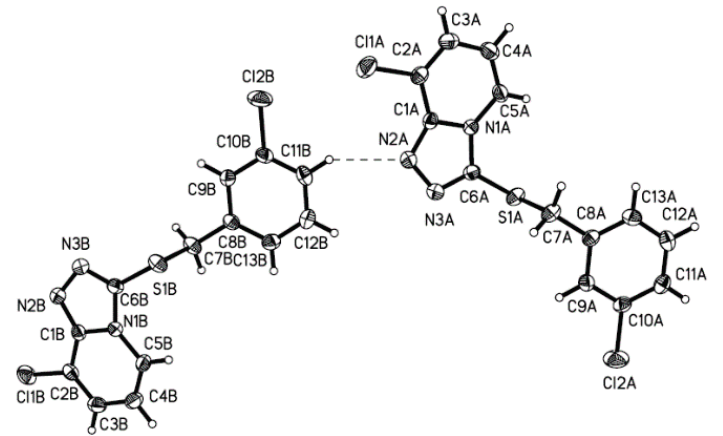
Figure 3. The pack of title